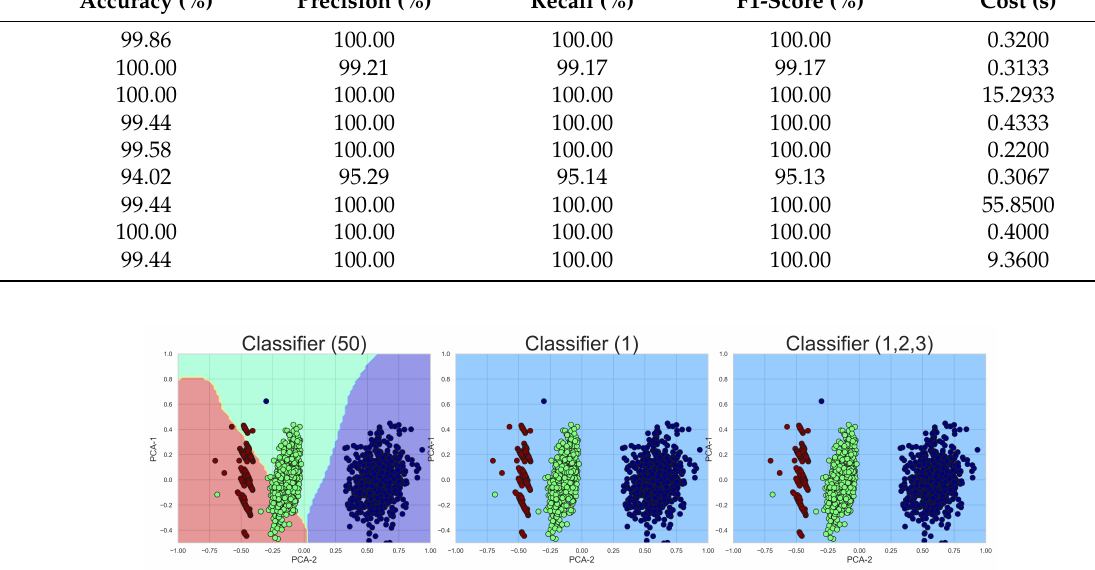
Figure 19. Fault Visualization plot aided with PCA for a ESR